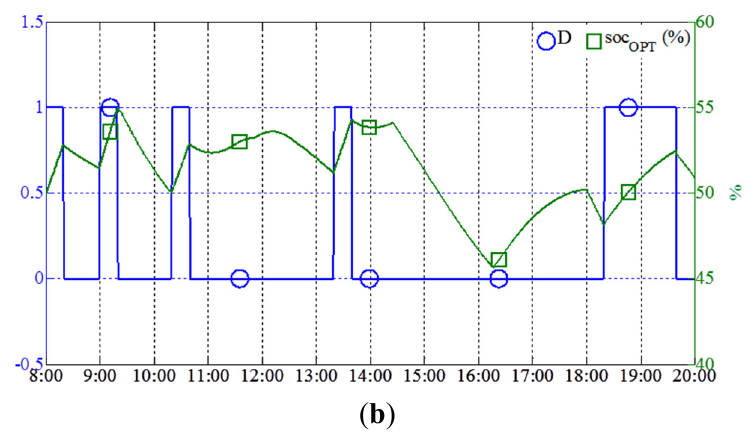
Figure 14. ( a ) Predicted and optimized power flow for Test 3; ( b ) D and soc evolution given by optimization for Test 3.